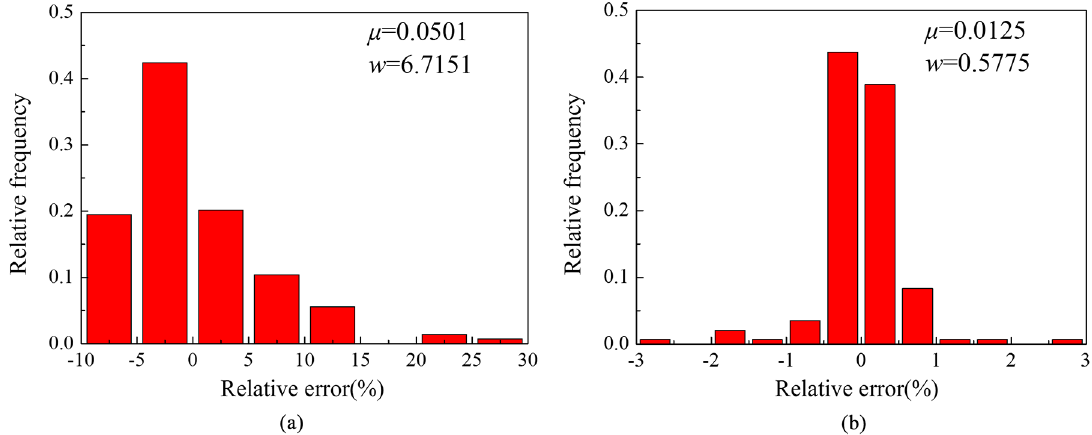
Figure 7. Distribution of relative percentage errors of all test data corresponding to (a) improved Arrhenius-type constitutive model and (b) BP-ANN model.